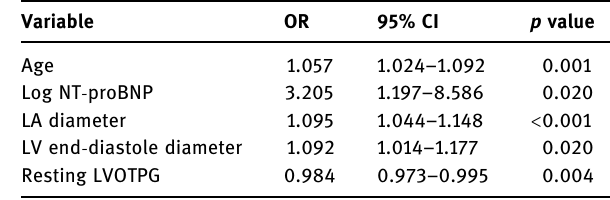
Table 3: Multiple linear regression analysis for the association between of LA diameter and variables in patients with hypertrophic